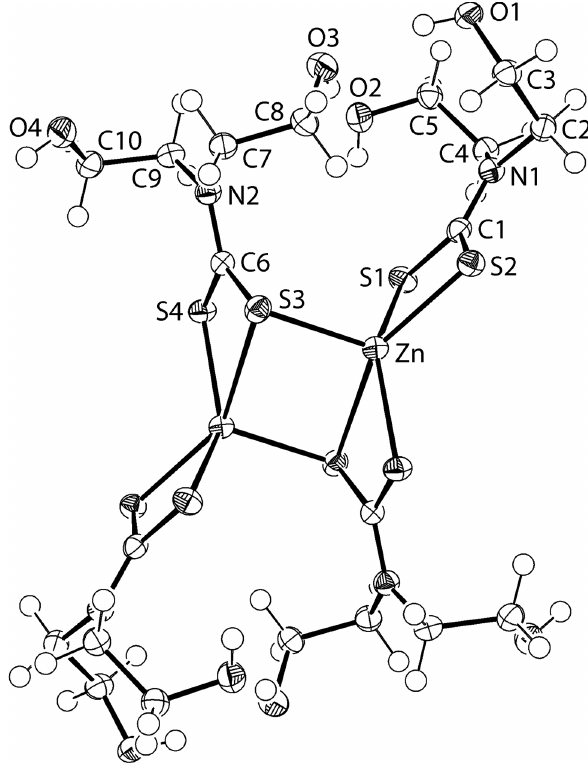
Table 1: Data collection and